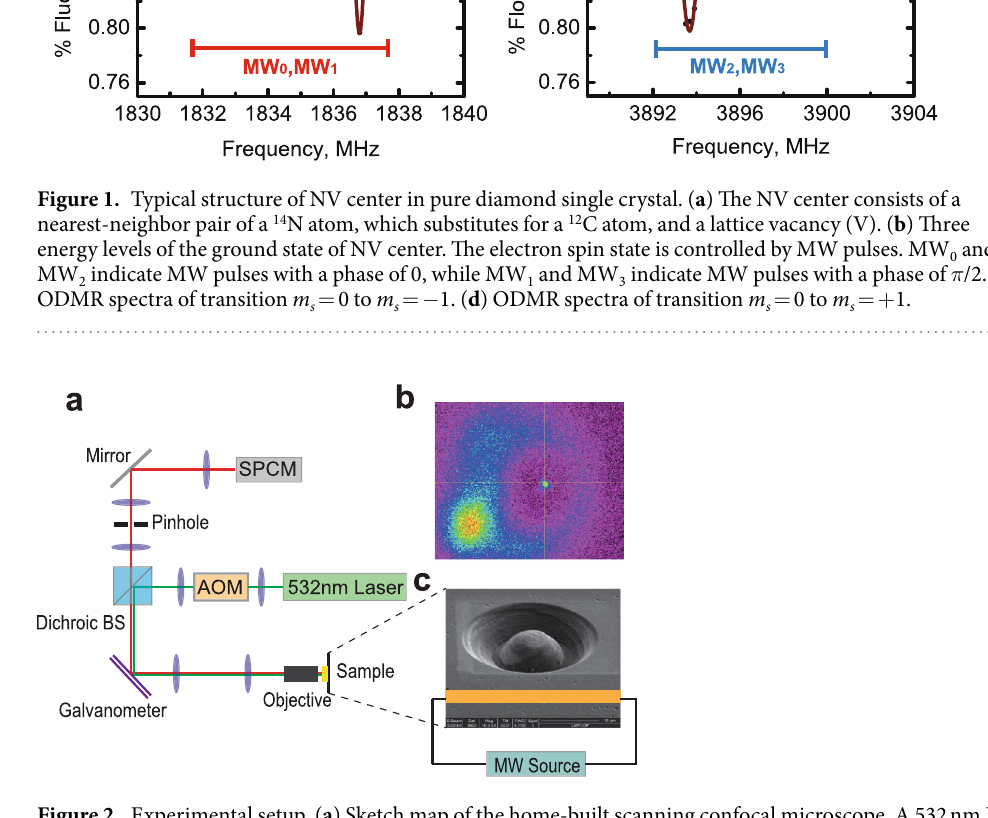
Figure 2. Experimental setup. ( a ) Sketch map of the home-built scanning confocal microscope. A 532 nm Laser beam from laser device is switched by an acoustic optic modulator (AOM) and focused on the sample through a microscope objective. The fluorescence of NV center is collected by the same objective and detected by the single photon counting meter (SPCM). The galvanometer is used to perform an X-Y scan of the sample while the dichroic beam-splitter (BS) is used to split the fluorescence of NV center and Laser. ( b ) Typical fluorescence scanning chart of the SIL and the NV center in it. ( c ) Typical photo of the SIL taken by electron microscope and sketch map of microwave